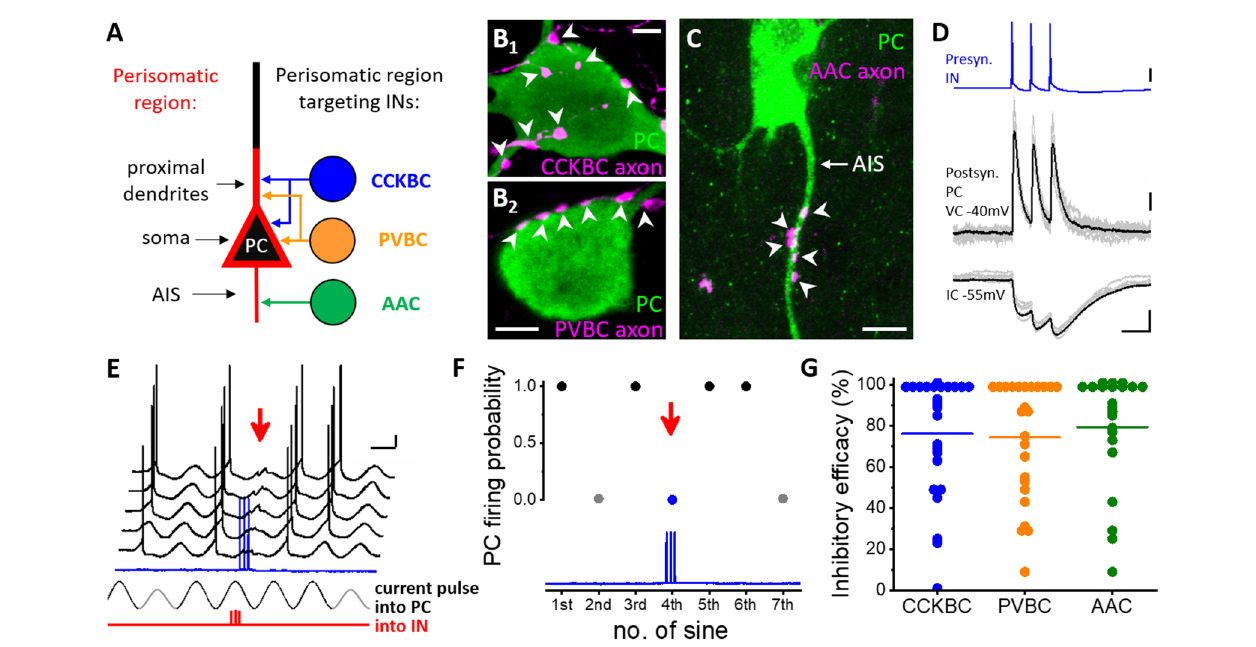
FIGURE 2 | Distinct types of perisomatic region-targeting interneurons provide equally potent synaptic inhibition onto the principal cells in the BLA. (A) Persiomatic region is composed of the soma and the spine-free proximal dendrites as well as the axon initial segment (AIS). This region of the principal cells (PC) is innervated by three interneuron (IN) types: cholecystokinin-expressing basket cells (CCKBC), parvalbumin-containing basket cells (PVBC), and axo-axonic cells (AAC). The two basket cell types target overlapping membrane domains of principal cells, whereas their axon initial segments are selectively innervated by axo-axonic cells. (B 1 –B 2 ) Axonal varicosities of a basket cell axon (BC, magenta, left) and (C) axo-axonic cell axon (AAC, magenta, right) form close appositions with the soma and proximal dendrite (arrowheads, left) and the AIS (arrowheads) of a principal cell (PC), respectively. (D) Three action potentials of a presynaptic interneuron (IN, in this case, a CCKBC) evoke postsynaptic responses in a principal cell (PC) recorded in voltage clamp (VC) and current clamp (IC) mode. (E) Testing the capacity of a perisomatic region-targeting interneuron (CCKBC) to inhibit spiking in a principal cell. Sinusoidal current trains were injected into the principal cell (PC), and three action potentials were evoked at 30 Hz in the interneuron (red, IN) 30–40 ms before the peak of the fourth cycle. Red arrow indicates the inhibitory postsynaptic potentials and lack of action potential generation in the principal cell caused by the presynaptic interneuron spike train (blue). Voltage traces are offset for clarity. (F) Summary plot of the experiment shown in (D) . Firing of the PC was prevented when the presynaptic CCKBC spiked three action potentials (red arrow). (G) Comparison of the inhibitory efficacy of three interneuron types targeting the perisomatic region. The inhibitory efficacy shows the probability of the suppression of spike generation in the principal cell by interneuron firing. At the population level, there is no difference in the efficacy of synaptic inhibition elicited by three perisomatic region-targeting interneuron types. Each dot represents the inhibitory efficacy obtained in a paired recording, line indicates median. This plot combines data published in (Veres et al., 2014, 2017). Scale bars: (B 1 –B 2 , C) : 5 µ m; (D) : upper panel: 20 mV, middle panel: 50 pA, lower panel: 2 mV and 50 ms; (E) : 10 mV and 200